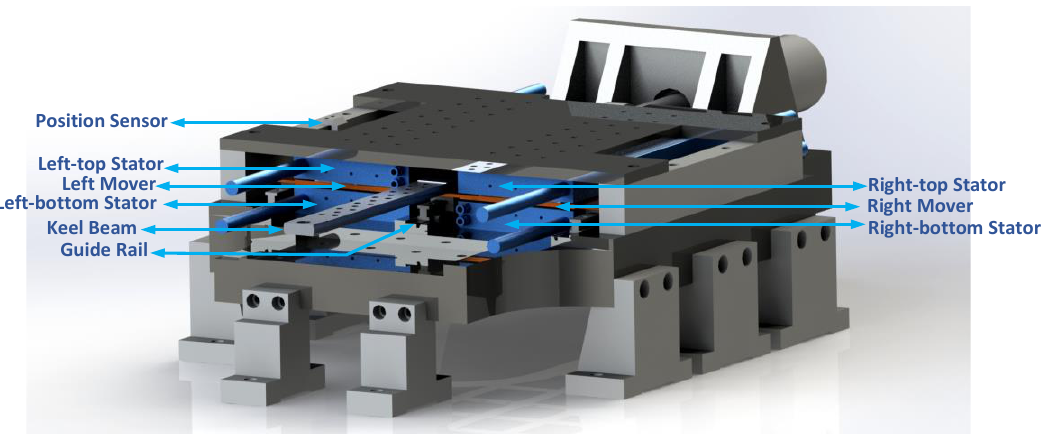
Figure 11. The 3D structure illustration of the linear electric machine.